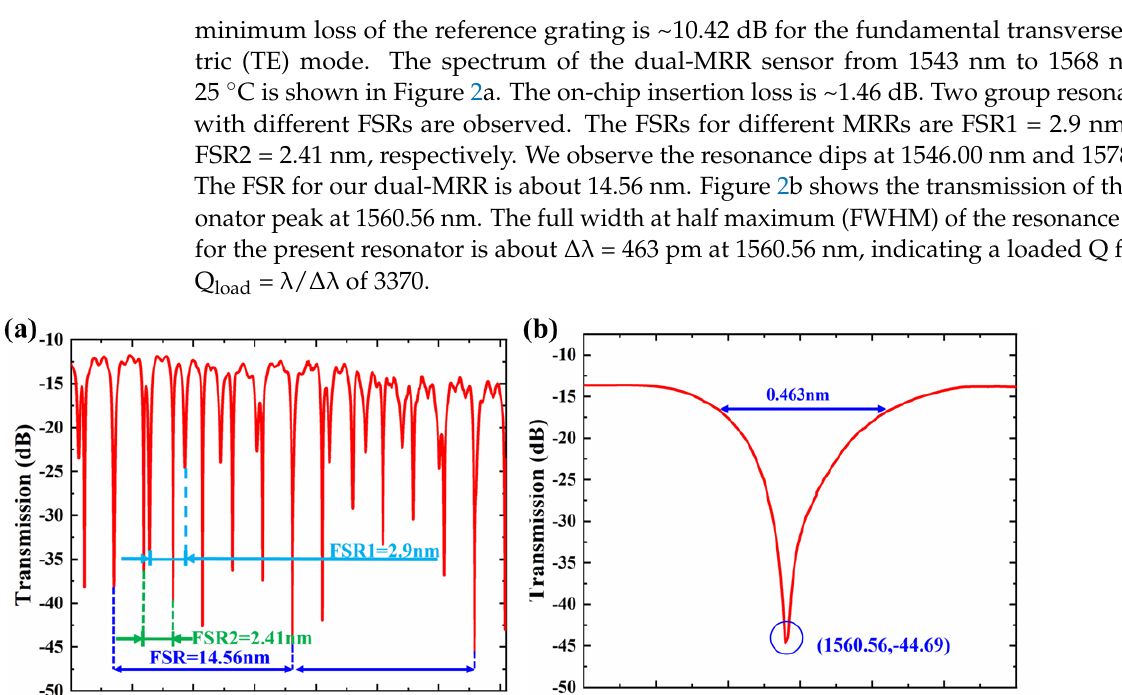
Figure 2. ( a ) The spectrum of the dual-MRR sensor. ( b ) The transmission of overlapping resonant peaks.